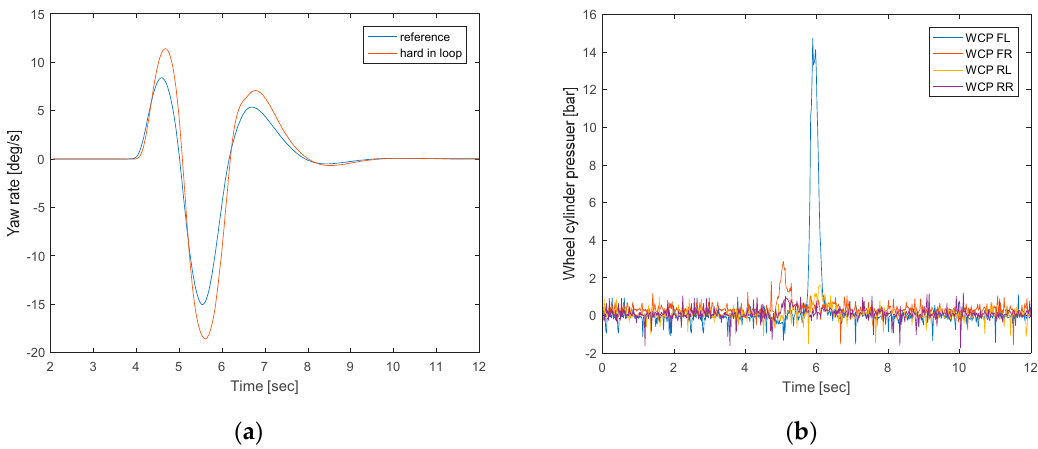
Figure 20. Test results based on the conventional PID-based controller at 𝑢 = 100 km/h and 𝜇 = 0.8.